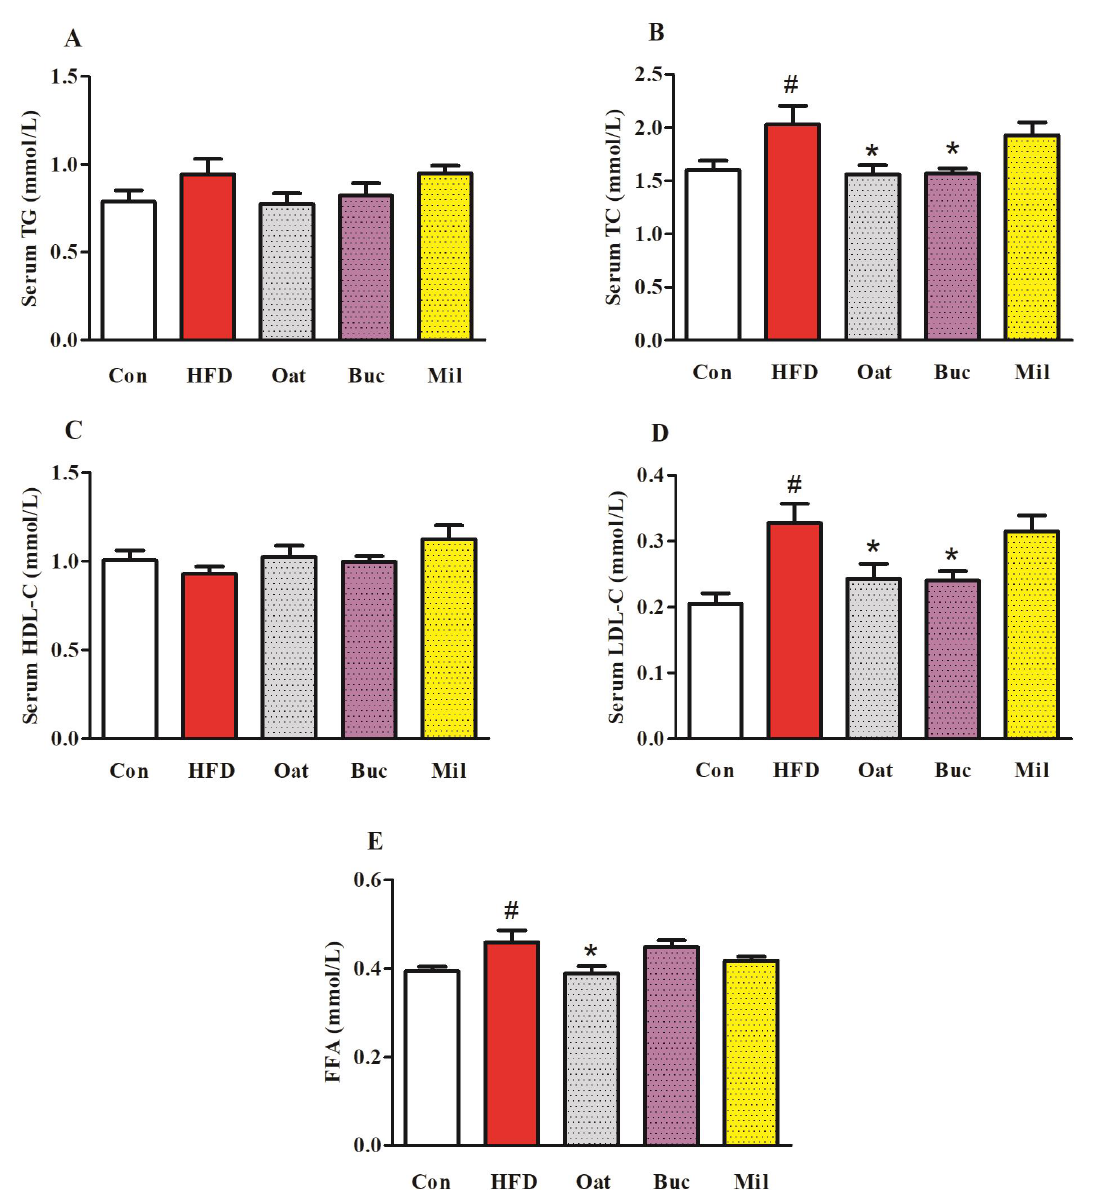
Figure 2. Effect of oats, tartary buckwheat, and foxtail millet supplementation on serum TG ( A ), TC ( B ), HDL-C ( C ), LDL-C ( D ), and FFA ( E ) in high-fat diet fed rats. Con group, a basal diet group; HFD group, a high-fat diet group; Oat group, HFD containing 22% oat group; Buc group,